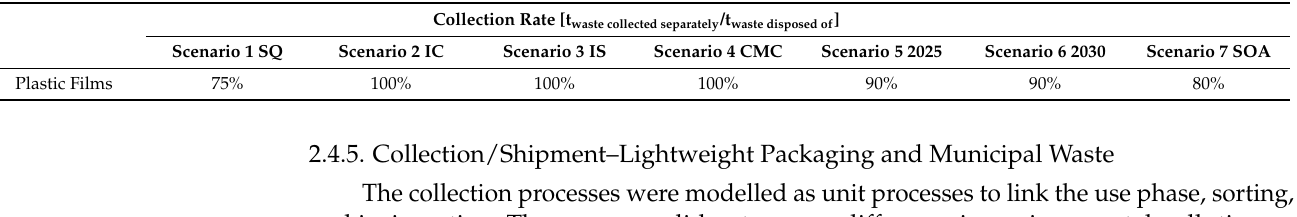
Table 3. Collection rates of the LVP